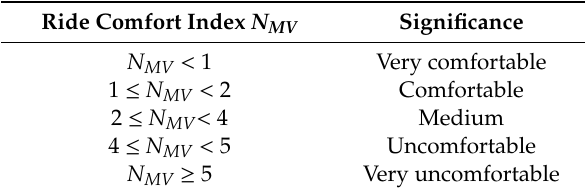
Table 1. The significance of the ride comfort index N MV